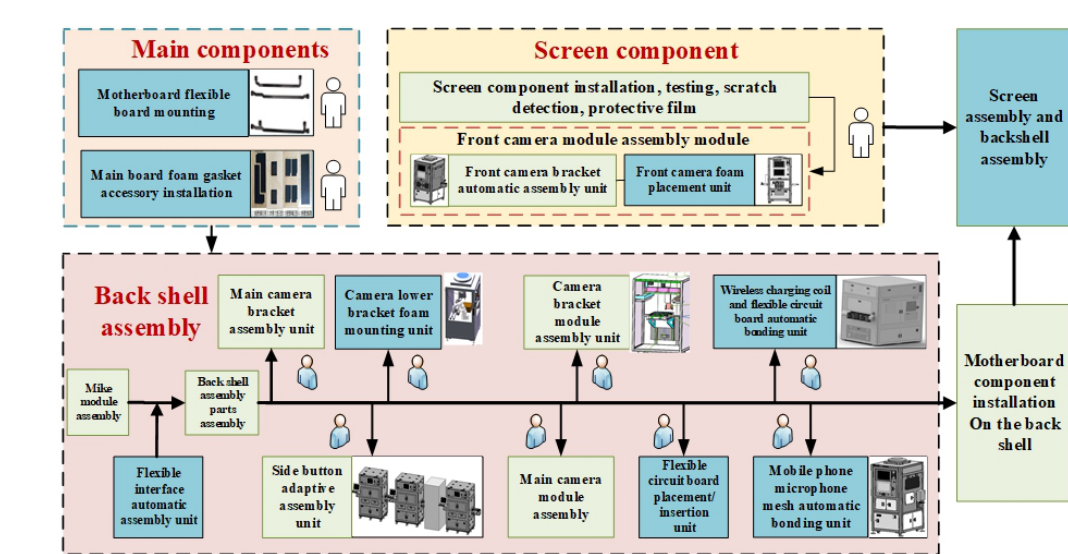
Figure 2. The assembly process of mobile